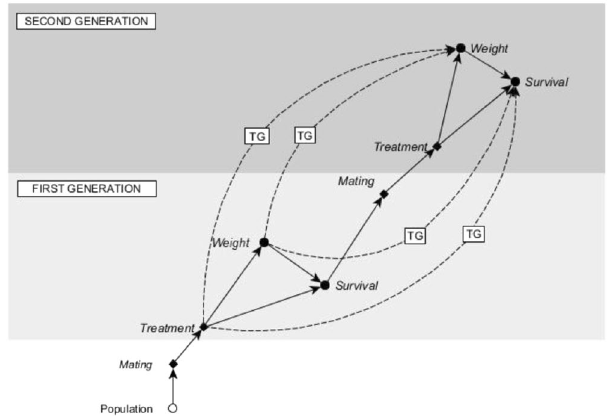
Figure 4. Experimental design to test the within- and transgenerational effects of sublethal insecticide exposure on survival and body mass in the Colorado potato beetle. Here the progress of the study is visualized by the ordering of the nodes. The vertical axis describes the observational time and different generations and the horizontal axis describes the causal order of events. Here the dashed arrows correspond to transgenerational (TG) causal relationships. For example, the treatment of the first generation parents has an effect on body mass of the offspring in the second generation. Open circles denote unobserved variables. Filled circles denote variables that have been measured from the sample. Similarly, diamonds denote variables that have been determined by the researcher, such as the assigned treatments or mating of each generation in this case. Our graphical presentation is a simplified version of 66